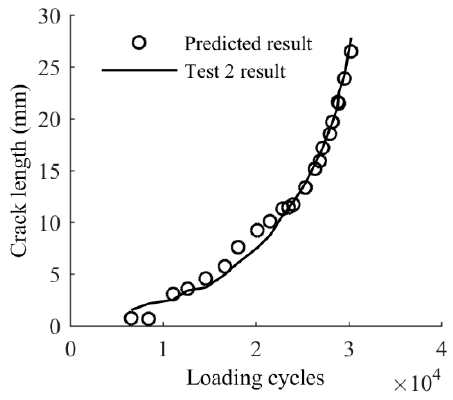
Figure 13. Updated model predictions of crack growth of Test 2.